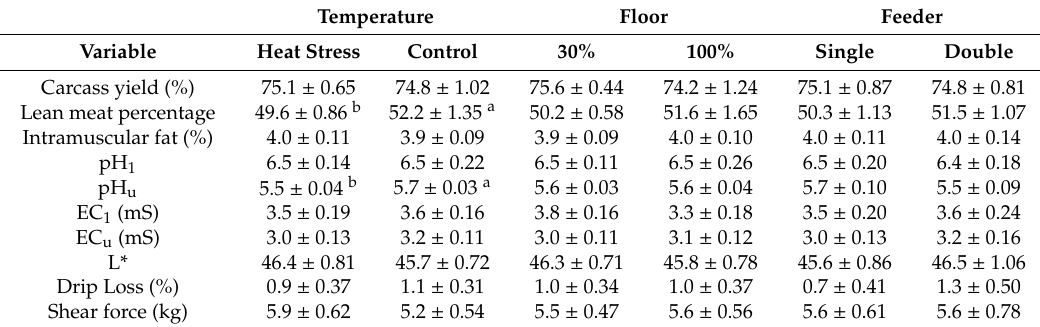
Table 4. E ff ect of temperature (heated room vs. control room), type of floor (30% slat 70% concrete vs. 100% slat), and number of feeders (one: single; two: double) on carcass and meat-quality